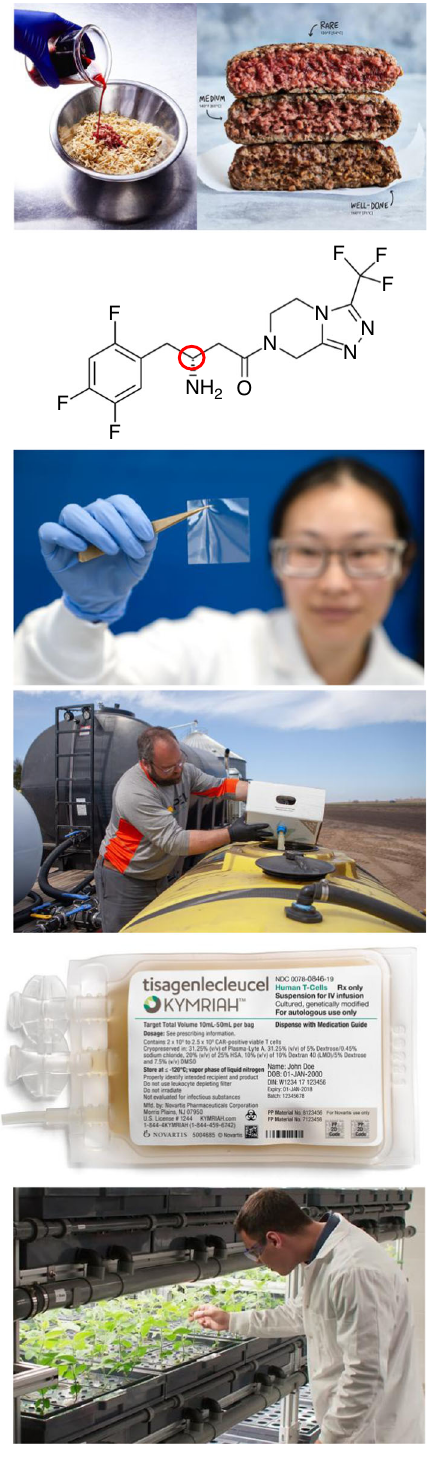
Fig. 1 Products from synthetic biology. (Top to bottom) Heme being produced to make an Impossible Burger. Sitgaliptin, with the enzymatically produced stereocenter shown in red. Hyaline transparent and fl exible fi lm. ProveN fertilizer being applied to corn. Kymriah, produced by genetically modifying a patient ’ s T cells. Calyno high-oleic oil from soy. Images were reproduced with permission from Impossible Foods, Zymergen, Pivot Bio, Novartis, and Calyxt,